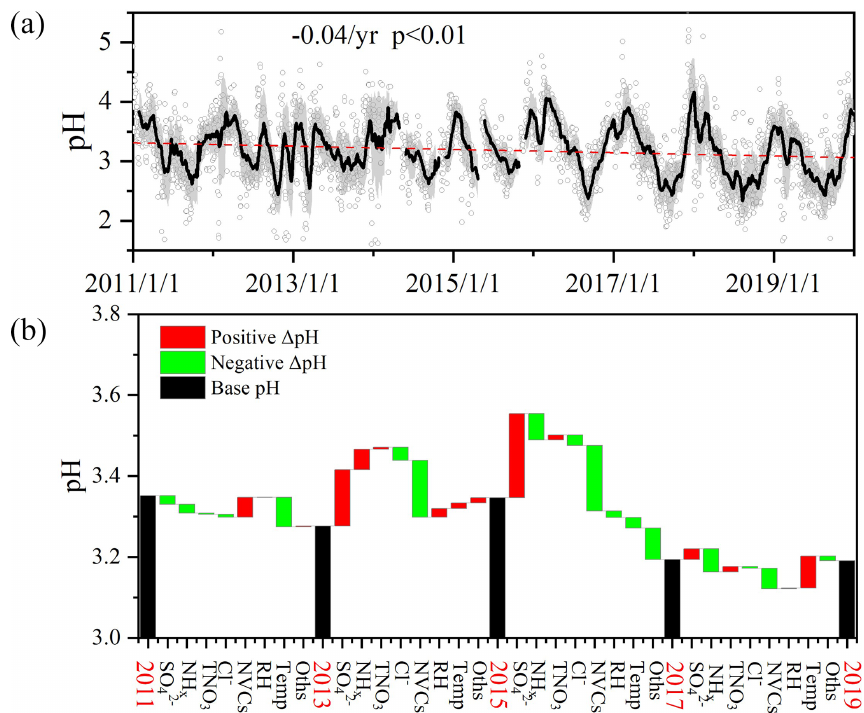
Figure 1. (a) Long-term trends in aerosol pH during 2011–2019 in Shanghai. Gray dots and black lines represent the daily pH values and 30d moving average pH values, respectively. Shaded areas mark the standard deviation of 30-day moving average pH values. (b) Contributions of individual factors to the (cid:49) pH from 2011 to 2019. Here the black bars indicate the mean pH of different years, and the red and green bars represent the positive and negative effects of individual factors on (cid:49) pH between two adjacent scenarios, e.g., 2011 and 2013, respectively. The meanings of the abbreviations: RH, relative humidity; Temp, temperature; NVCs, non-volatile cations; NH x , total ammonia; TNO 3 , total nitrate; Oths,